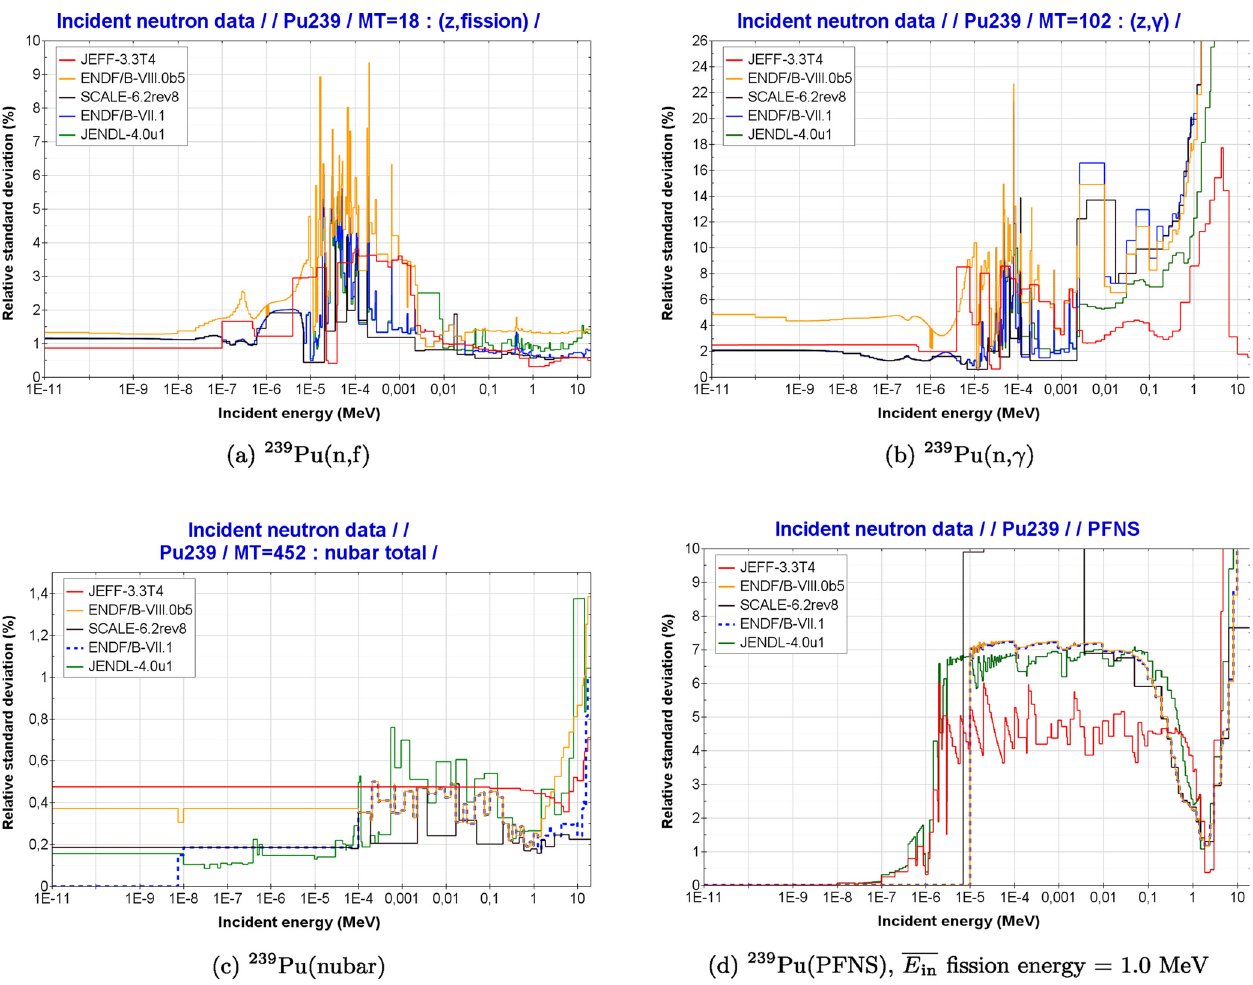
Fig. 2. Relative standard deviation (%) for 239